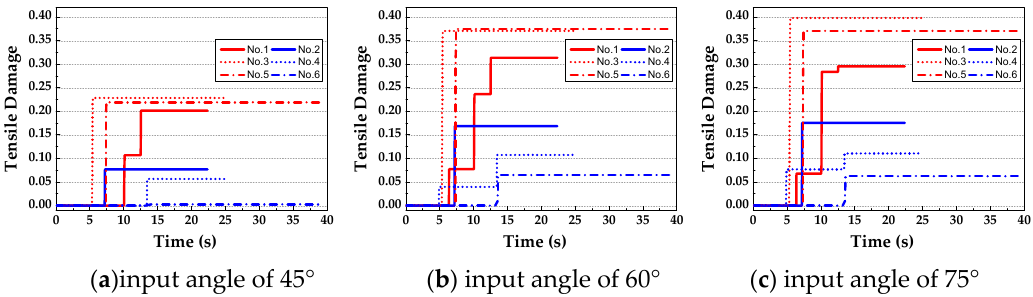
Figure 15. Tensile damage on inflection point D of the dam.